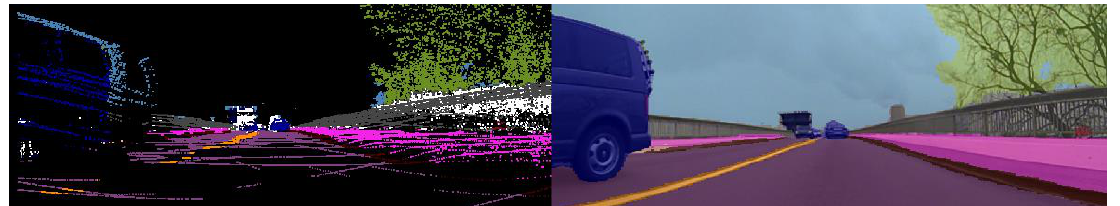
Figure 10. Semantic class of each 3D point. On the left-hand side, we observe the assigned semantic class of each projected 3D LIDAR point. In the right image, the semantic class image with 50% transparency is overlapped over the color image.